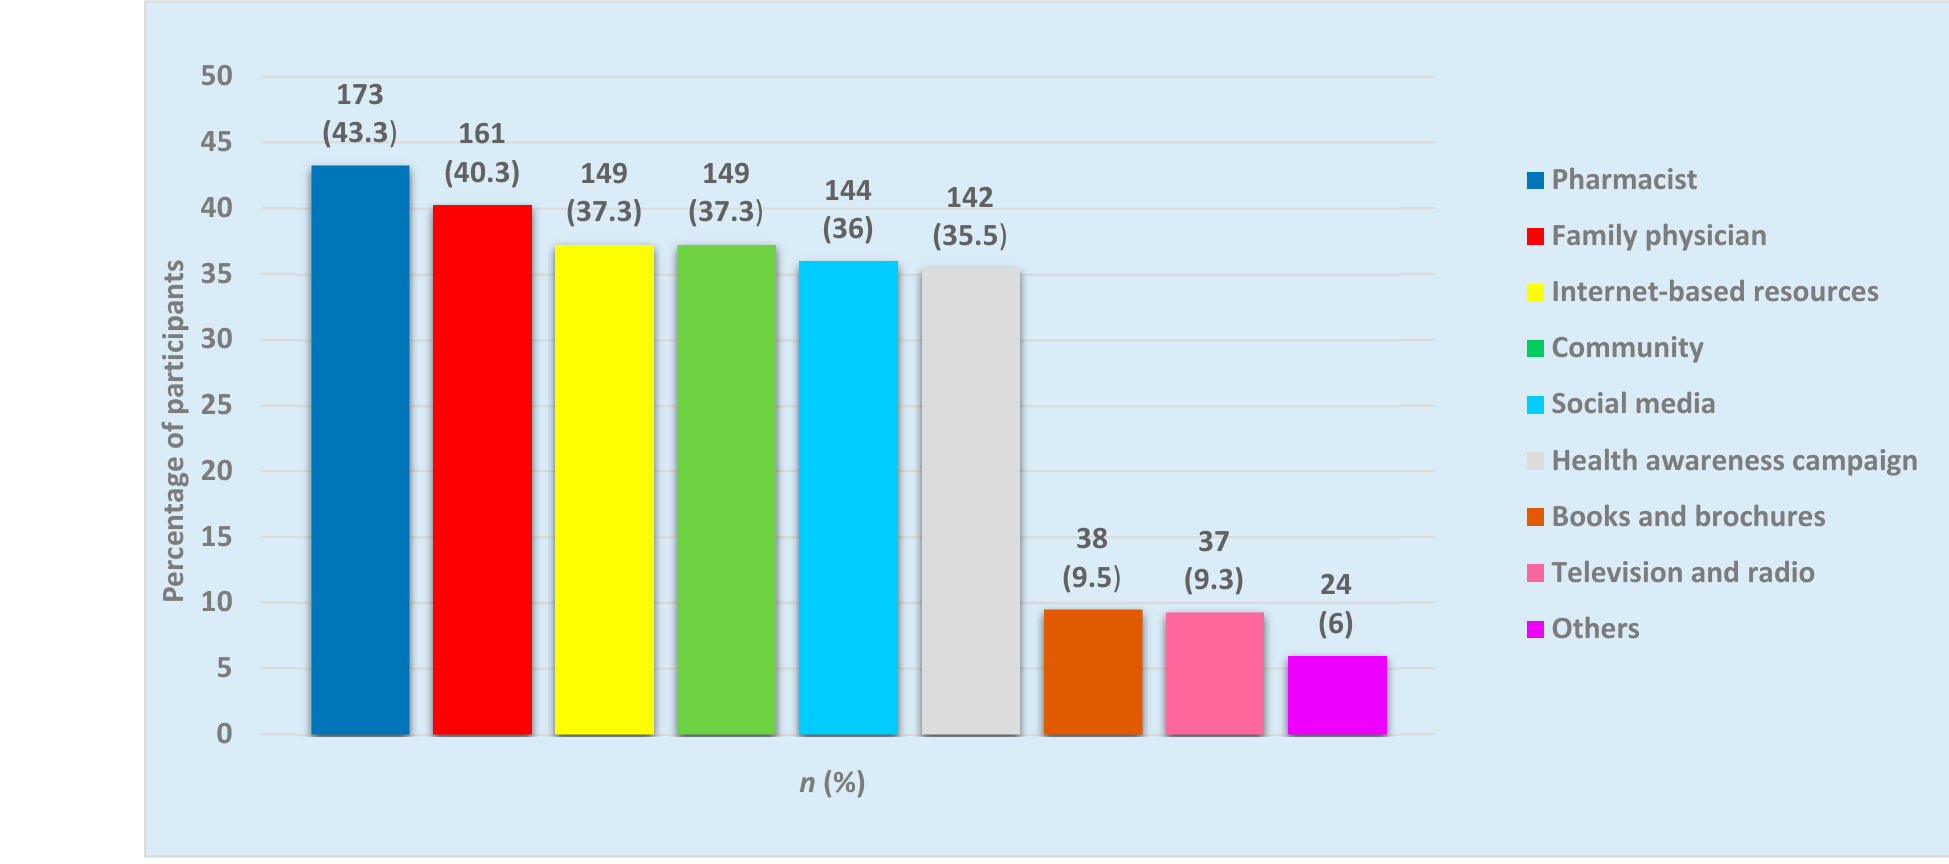
Figure 2. Participants’ sources of information about the eye diseases.